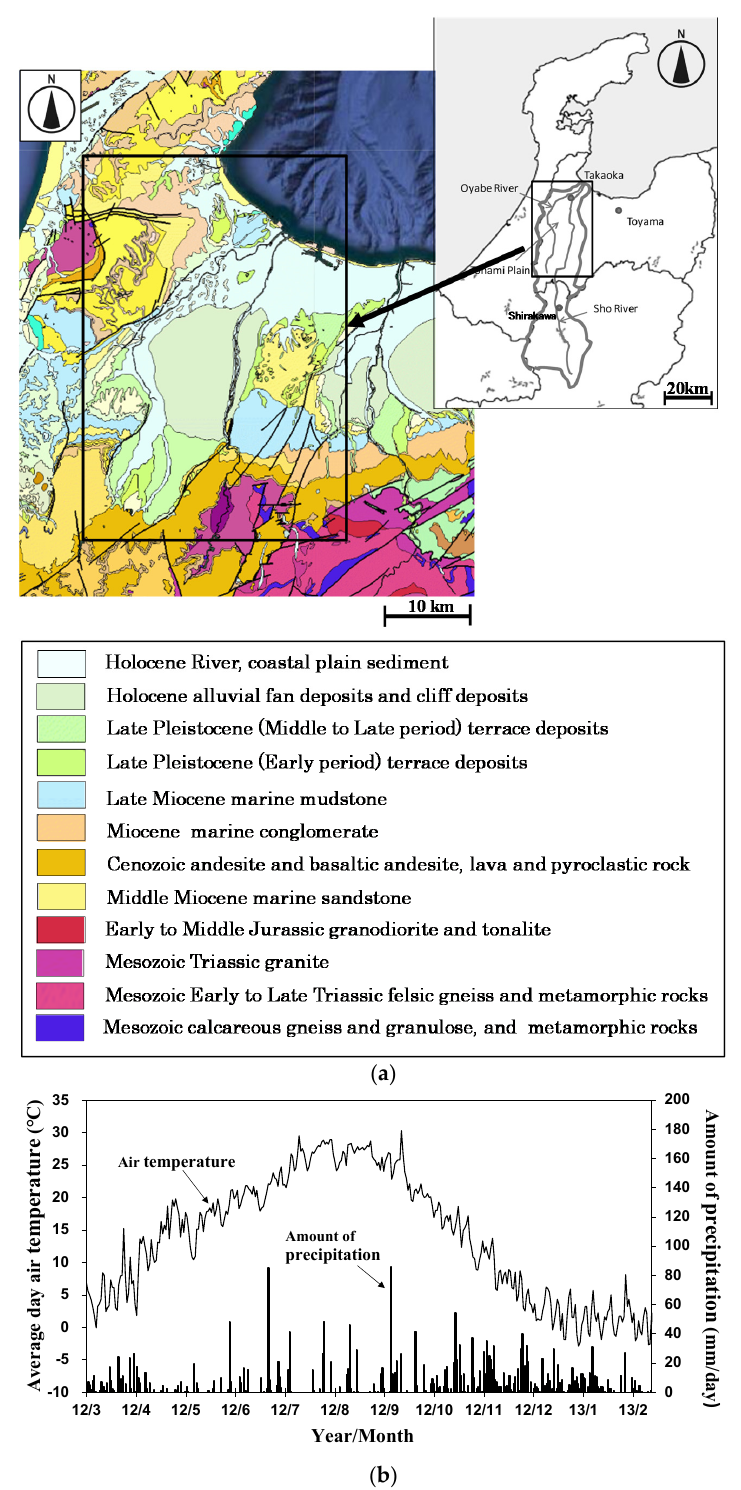
Figure 1. ( a ) Geological map of the study area [1]. ( b ) Average daily air temperature and precipitation at Takaoka City